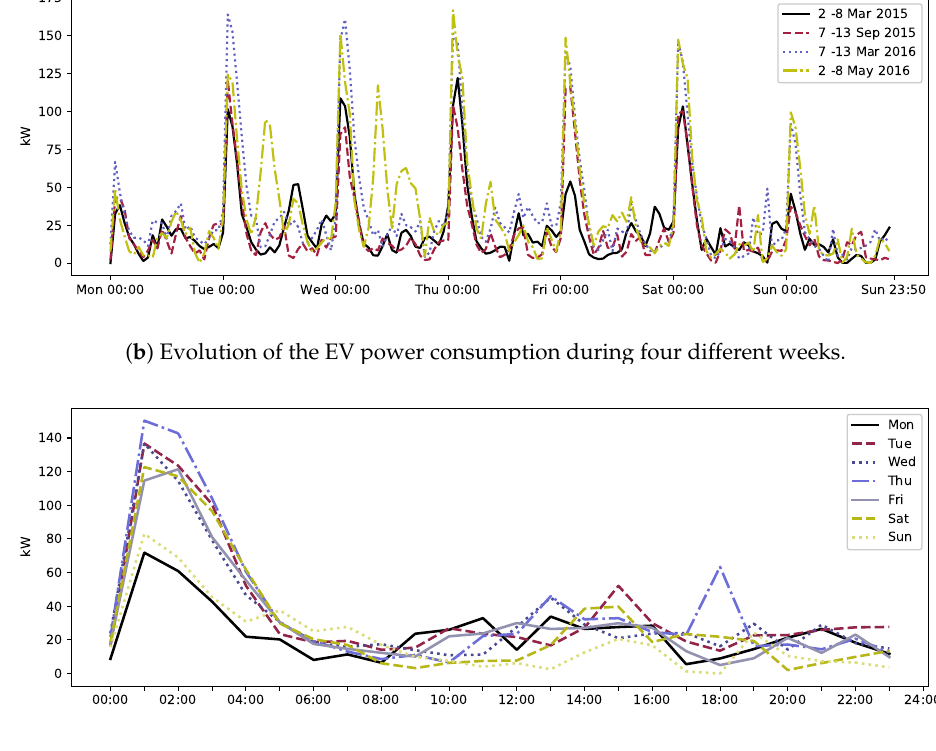
Figure 2. Line plots illustrating the electric vehicle power consumption data at different